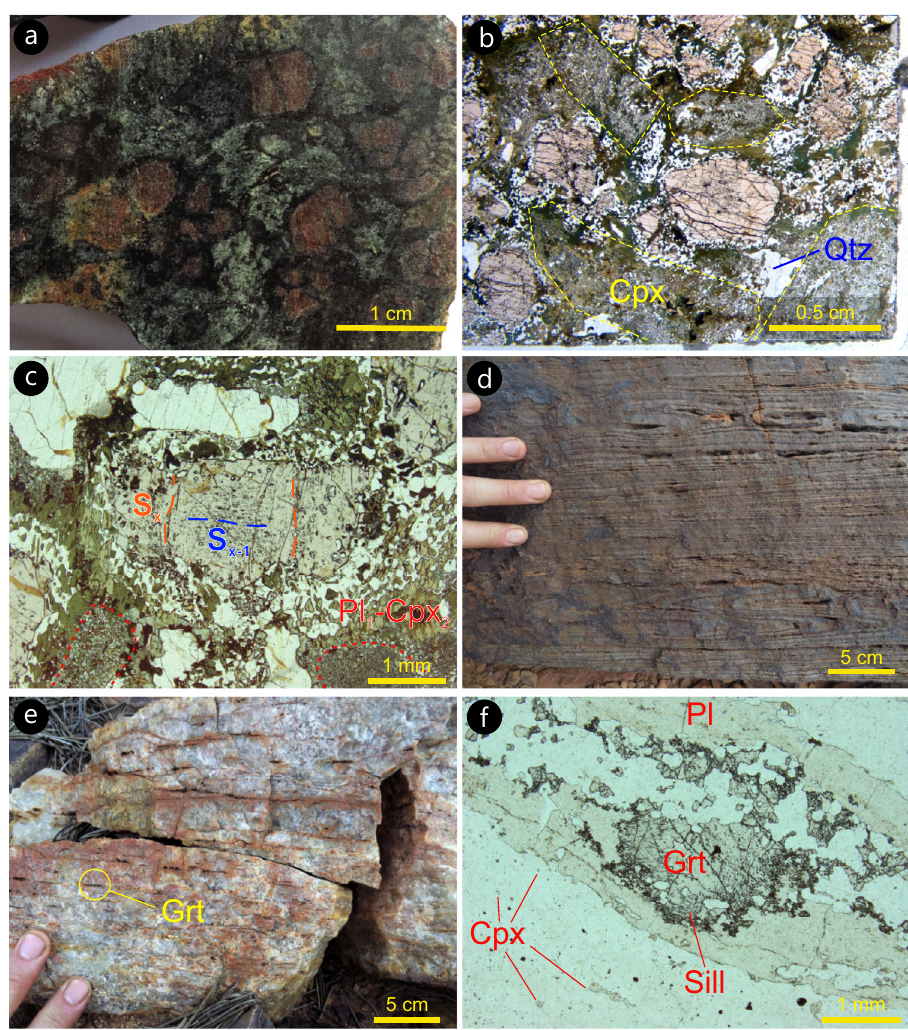
Fig. 4 | Typical meso- and microscale features of the main rock types in the Waroonga greenstonebelt. a Polishedhand specimen(sample 209029)from the core of a garnet amphibolite body. Subhedral to euhedral, cm-sized garnet and pale-green clinopyroxene porphyroblasts (M1 assemblage) show variable degrees of retrogression, as marked by hornblende-rich black rims. b Plane polarized light view of hand sample shown in a , highlighting the texturally preserved peak (M1) assemblage of clinopyroxene, garnet, quartz and rutile. Peak pyroxene (Cpx1), whose outline is marked by dashed yellow lines, is replaced by clinopyroxene (Cpx2) – plagioclase1 symplectites (M2 assemblage) and by hornblende – plagioclase2 symplectites. The latter developed at the expenses of